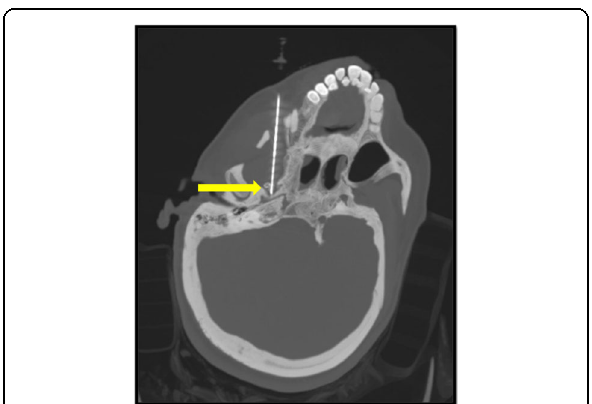
Fig. 15 Axial CT section of the skull base with the needle tip at the foramen ovale (straight